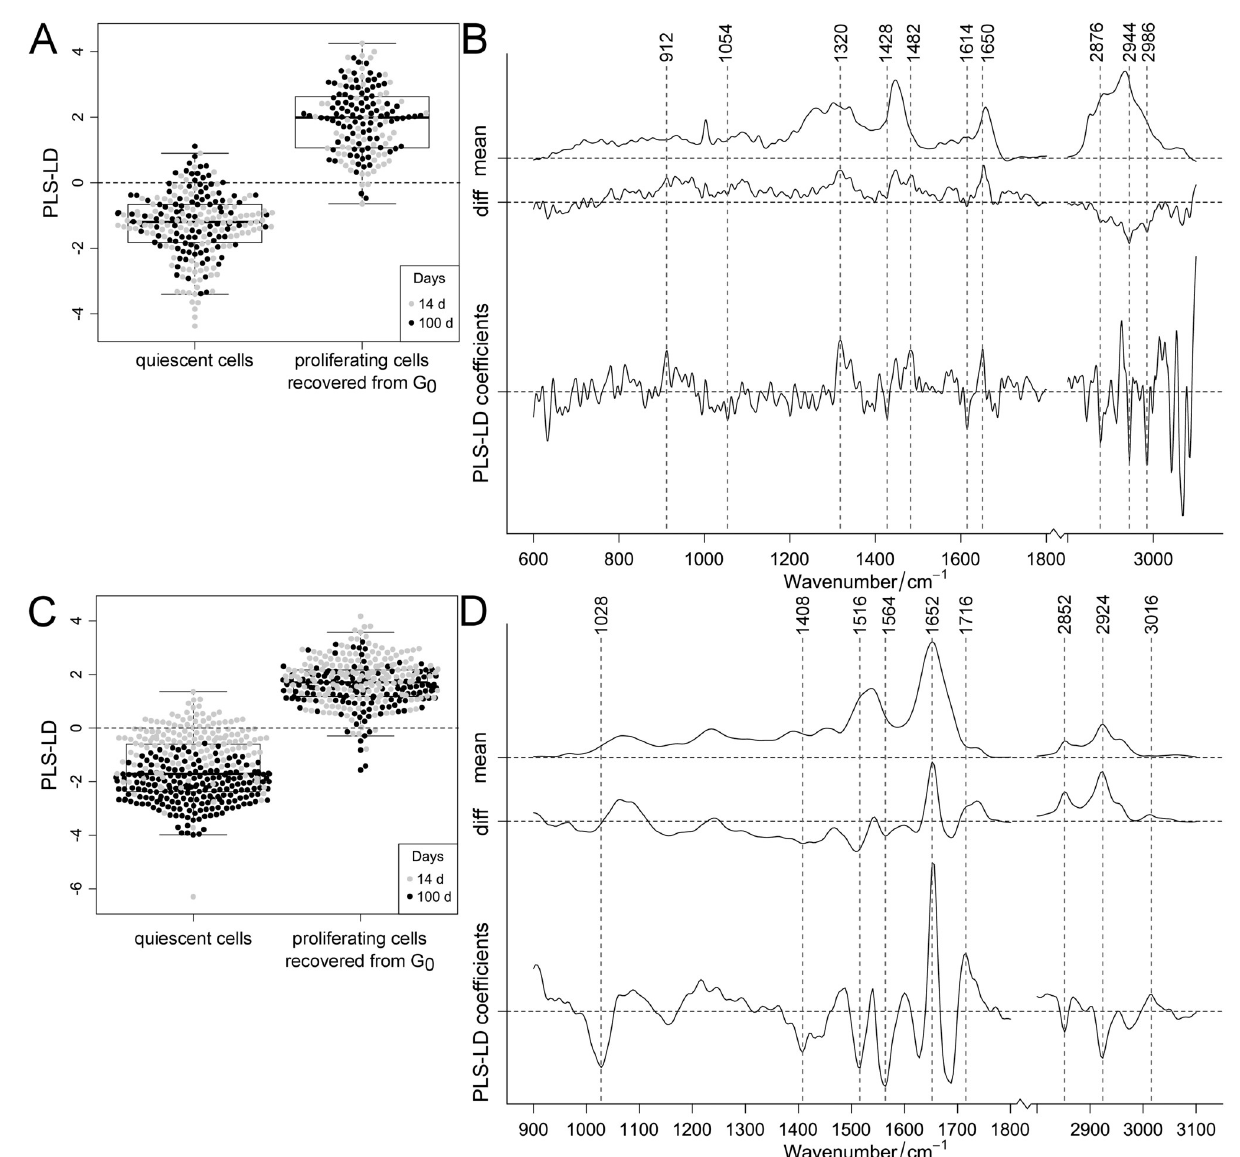
Fig 4. Classification of quiescent cells and proliferating cells recovered from quiescence. PLS-LDA of Raman (A, B) and FT-IR spectra (C, D) of contact-inhibited quiescent cells and proliferating cells recovered from quiescence after 14 and 100 days. Distribution of cells shown in one- dimensional scatter plots combined with box-plots (A, C) showing 95% confidence interval with p-values < 0.001 for Raman and FT-IR data. Cultivation time was specified by color (14 days: gray, 100 days: black). Mean and difference spectra (“diff”, proliferating cells recovered from quiescence vs. quiescent cells) from the classified cells are plotted together with the PLS-LD coefficients vs. the wavenumber (B,